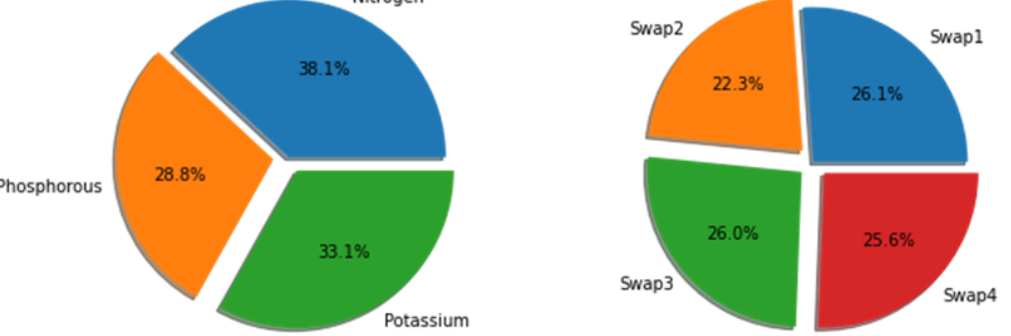
Figure 4. Class distribution of rice deficiency in the Kaggle dataset and Mendeley dataset.